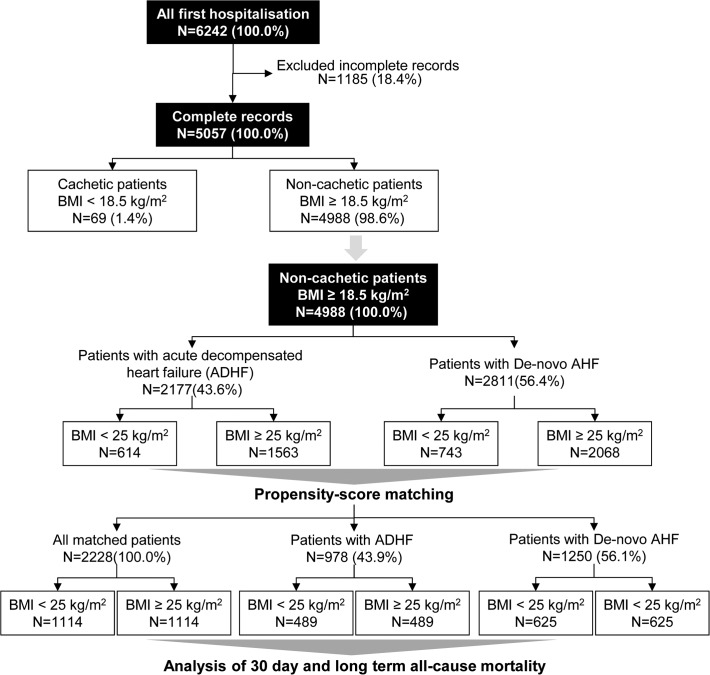
Thirty-day mortality according to BMI category.